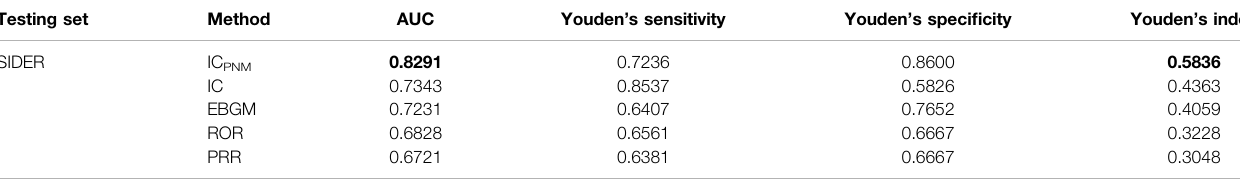
TABLE 3 | Results of performance of different signal detection algorithms using FAERS 2014 – 2019Q2 data. Testing set